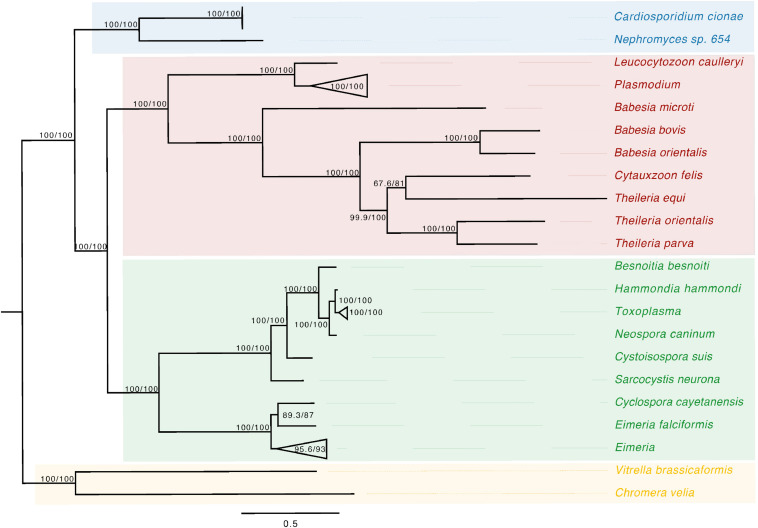
Apicoplast phylogeny created using a modified dataset provided by Muñoz-Gómez et al. (2019a), showing the monophyly of C. cionae and Nephromyces. The complete, circularized C. cionae apicoplast recovered from the genomic dataset, and Nephromyces apicoplast sp. 654, are shown in blue. The resolved topology differs from Muñoz-Gómez et al. (2019a) because of the exclusion of gregarines from our dataset, which includes Nephromycida (blue), Piroplasmida (red), Coccidia (green), and apicomonads (yellow) as the outgroup. Statistical support was estimated using aLRT (1,000) and ultrafast bootstrap (1,000) (Nguyen et al., 2015) and these values are shown in this order on the nodes.